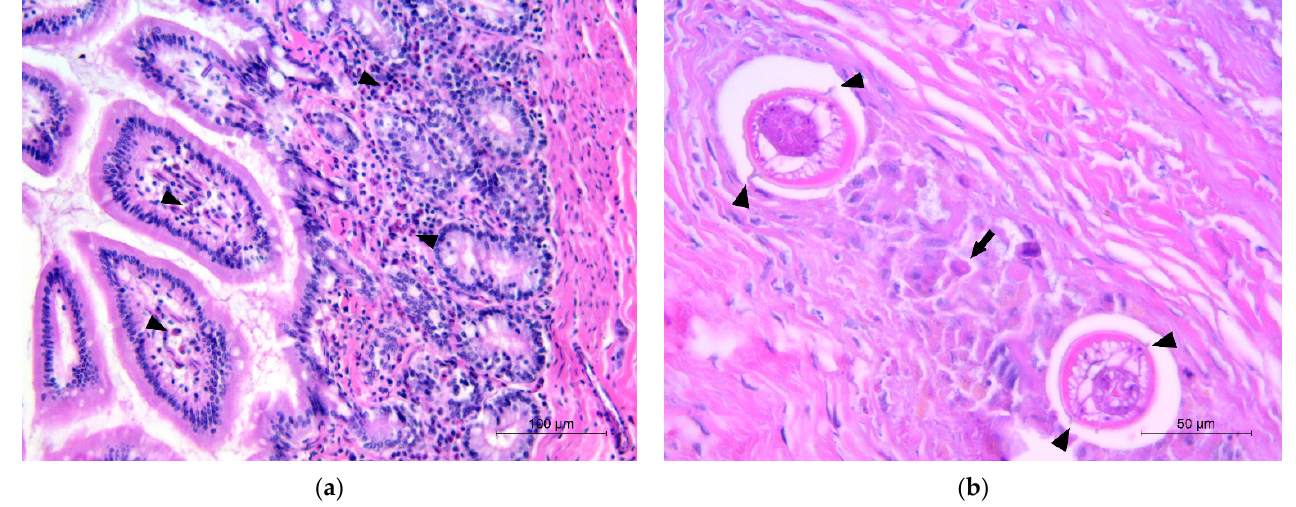
Figure 1. Histological sections of raccoon intestine. ( a ) Small eosinophilic aggregates in the lamina propria (black arrowheads); ( b ) larvae of B. procyonis in the ileal submucosa showing prominent lateral alae (black arrowhead) in the cross-section, associated with macrophages, eosinophils (black arrow), and cellular debris.